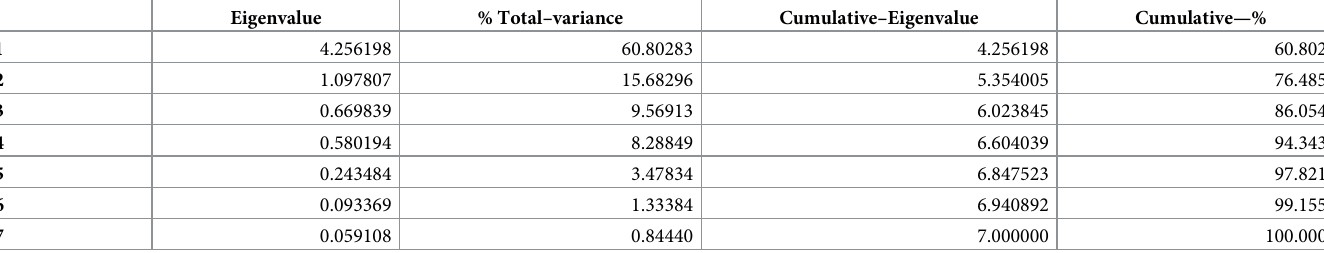
Table 3. Eigenvalues of indicators of political and institutional development.